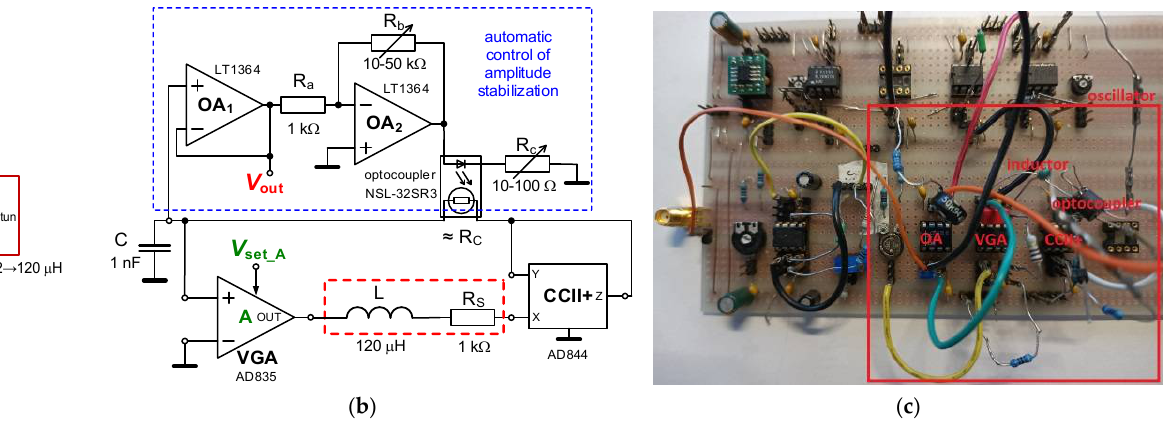
Figure 8. New electronically adjustable LC oscillator: ( a ) simplified ideal principle, ( b ) full topology including AGC, ( c ) PCB for experimental measurement (a universal board including adjustable in- ductor).